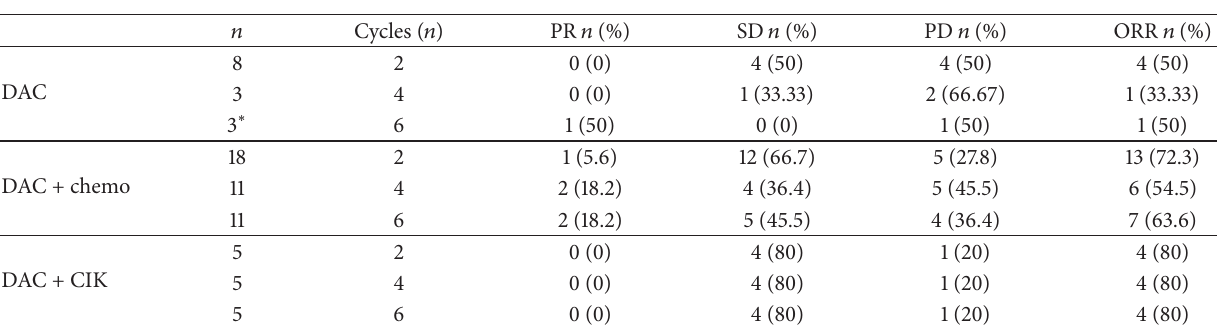
Table 4: (a) Result of clinical response. (b) Baseline diagnosis of patients who were assessed in the clinical response.